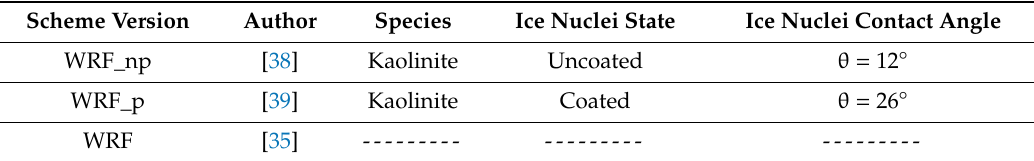
Table 2. Ice nucleation parameterization schemes used for the simulations. The original microphysical scheme (WRF) is based on the singular hypothesis, while WRF_np and WRF_p are based on the stochastic theory, which includes a contact angle ( θ = 12 ◦ and θ = 26 ◦ ,